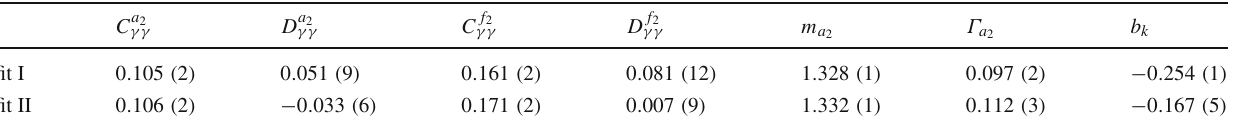
Fig. 8 Experimental γγ → K S K S differential cross-sections compared with the two fits results Table 3 Values of the coupling constants, of the subtraction constant b k and of the mass and width of the a 2 ( 1320 ) resonance resulting from the two fits